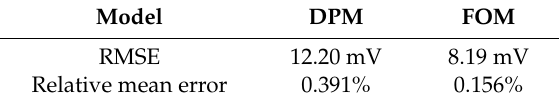
Table 6. RMSEs and relative errors for di ff erent SOC ranges.